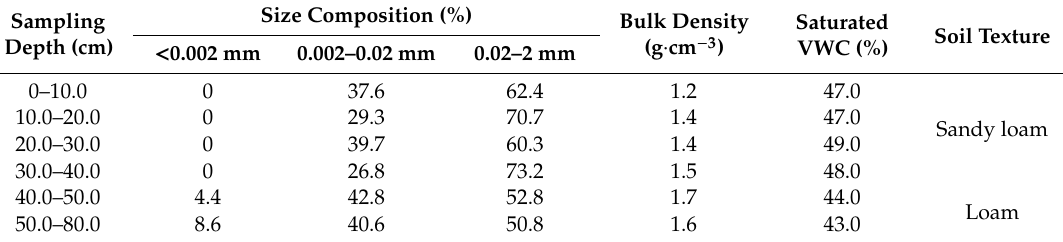
Table 2. Physical properties and the particle composition of the soil for experiment. VWC—volumetric water content.